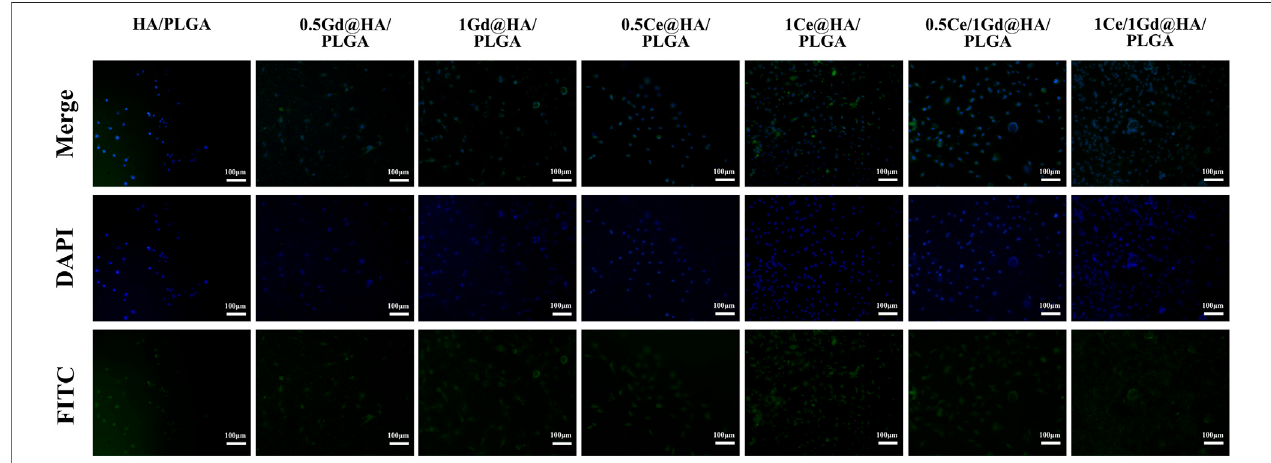
FIGURE 7 | Fluorescence micrographs of MC3T3-E1 cells on HA/PLGA, 0.5Ce@HA/PLGA, 1Ce@HA/PLGA, 0.5Gd@HA/PLGA, 1Gd@HA/PLGA, 0.5Ce/1Gd@ HA/PLGA, and 1Ce/1Gd@HA/PLGA nanocomposites cultured for 24 h. Cells were stained with FITC (green) and DAPI (blue). Scale bar, 100 μ